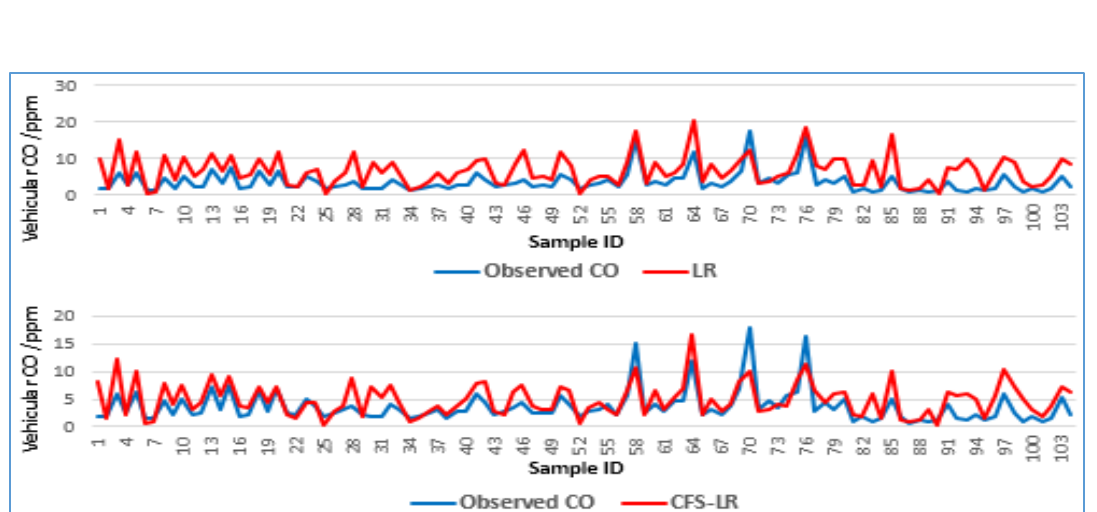
Figure 9. Comparison between the proposed and other models.